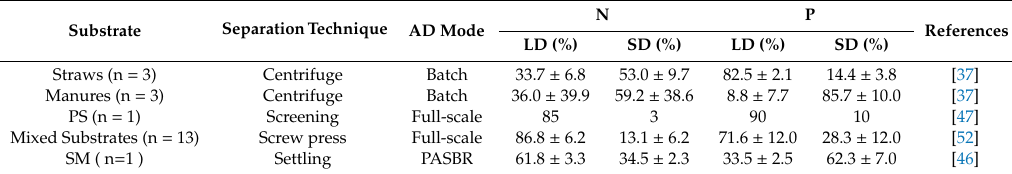
Table 4. Distribution of nutrients into LD and SD. “n” is the number of experiments to calculate the standard deviation of the mean ( ±